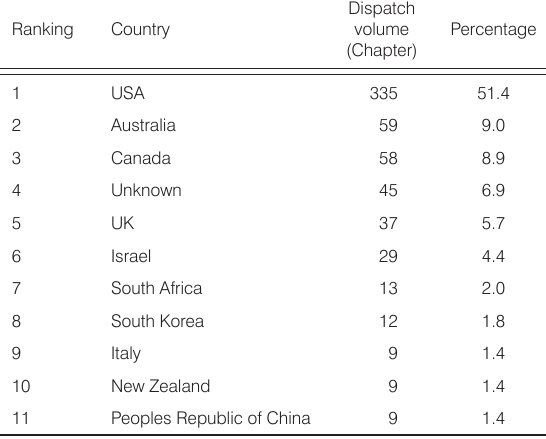
Table 1. Countries in the top 11 cases of compassion fatigue.